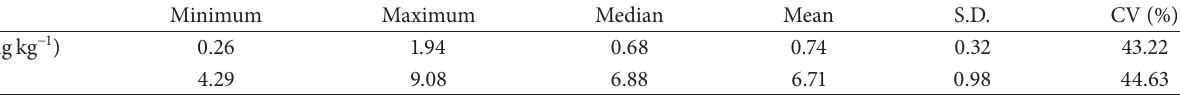
Table 2: Summary statistics of Cd concentration and pH in topsoil